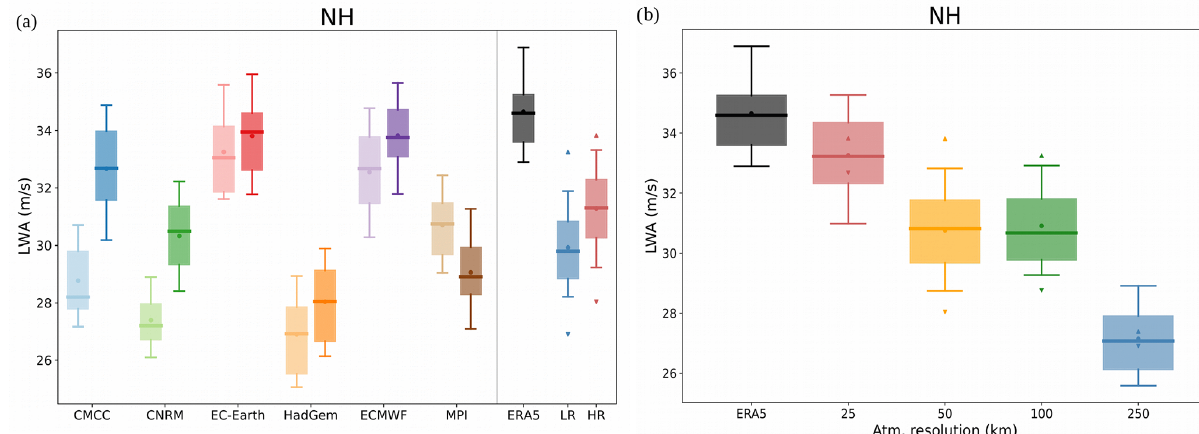
Figure 4. Panel (a) box plot of the seasonal means of transient LWA averaged over NH. The dots are the mean values, the horizontal line in the boxes represents the median, the boxes are the first and third quartiles, and the bars are the 10th and 90th percentiles of the distribution. The left boxes are for each PRIMAVERA model (lighter colours are the LR runs, darker colours the HR). The first (black box) on the right refers to ERA5. The other two boxes represent average quantities among all the lowest-resolution (LR) and highest-resolution (HR) model versions and are calculated as the average of the percentiles and median over all models. Panel (b) shows the grouped box plot following the nominal atmospheric resolution of each model: each box represents the average percentiles and median over all models in that group. ERA5 is shown on the left for reference. In this case models with intermediate horizontal resolutions (ECMWF and HadGEM) are